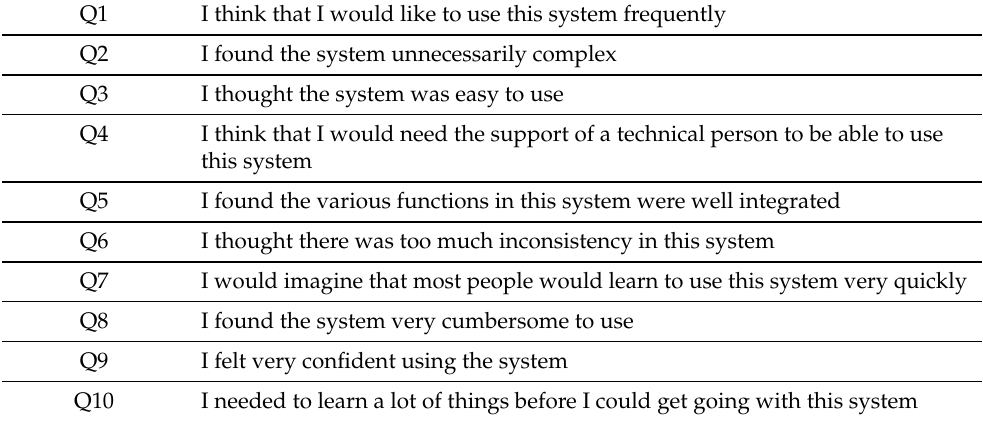
Table 1. Questions of the SUS questionnaire